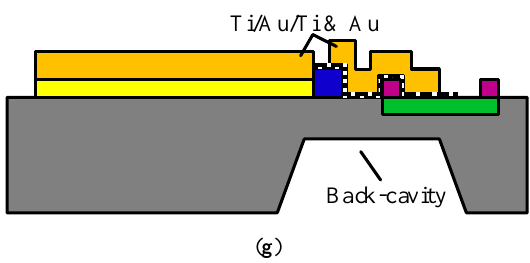
Figure 2. Fabrication process of the thermocouple-type RF MEMS power sensors with a thermal slug and a back cavity (dual thermal flow paths). ( a ) n + GaAs; ( b ) AuGeNi/Au; ( c ) TaN; ( d ) Ti/Pt/Au/Ti; ( e ) Si 3 N 4 ; ( f ) Ti/Au/Ti &Au; ( g ) Back-cavity.